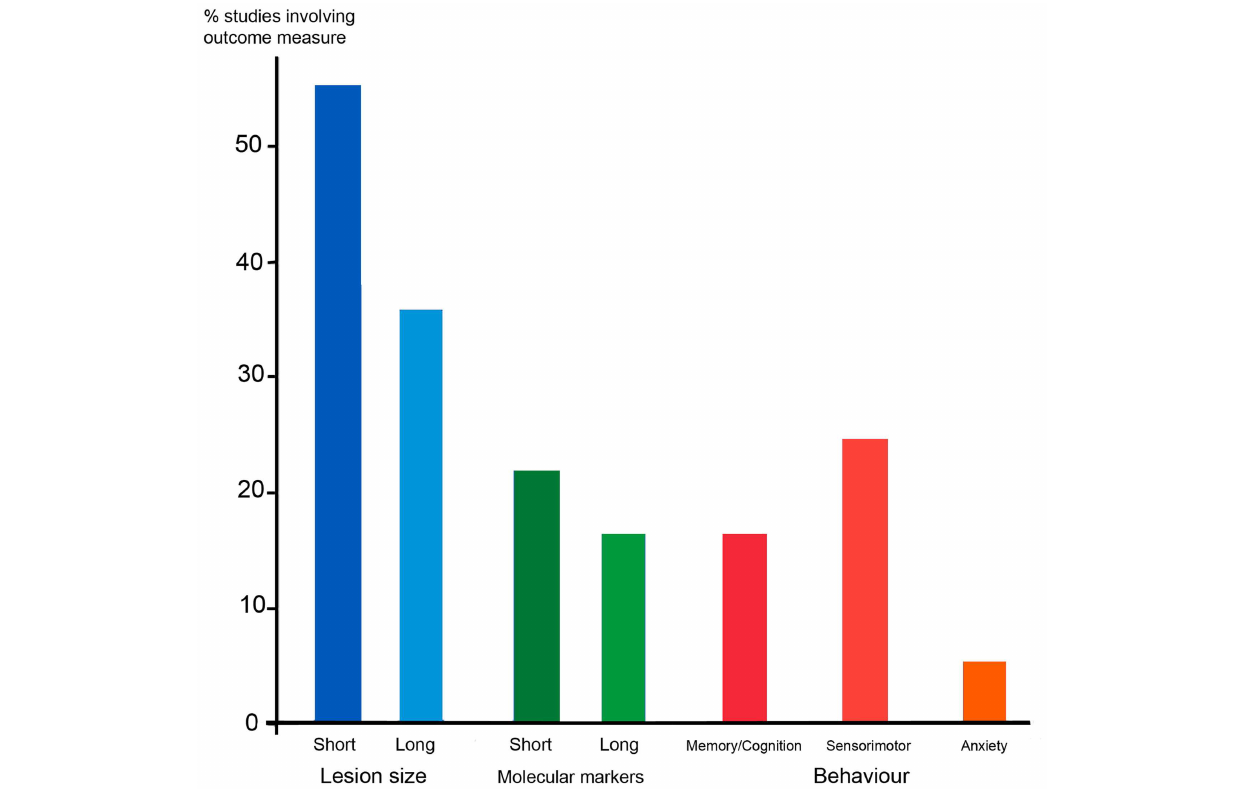
FIGURE 4 |The outcome measures employed in a sample of 36 rodent studies that modeled PVWMI or PIS, some of which involved experimental therapies . Blue columns depict the proportion of studies that studied lesion size in the short term (within a week) or in the longer term, either using MRI, or histology. Green shows studies of changes in molecular markers in response to lesions, e.g., markers of apoptosis, myelin, and